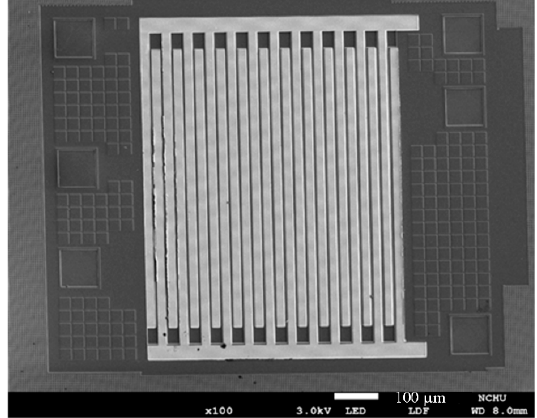
Figure 9. SEM image of the AGS after etching the oxide layer.